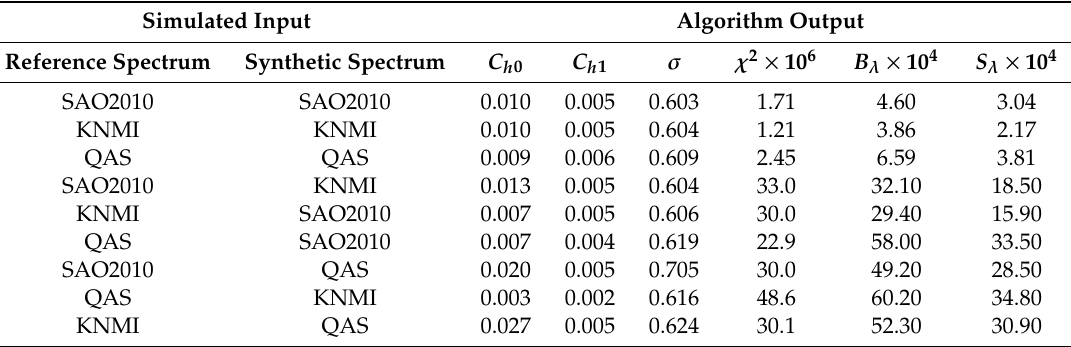
Table 8. Sensitivity results of the wavelength calibration algorithm using high-resolution reference solar spectra. Wavelength perturbations applied to the simulated input are identical to the other tests ( C h 0 = 0.01 nm; C h 1 = 0.005